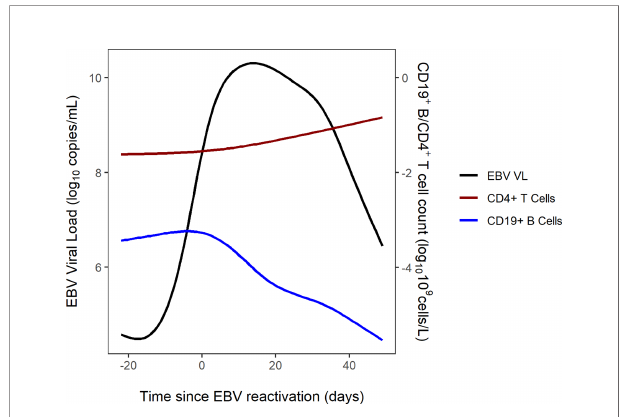
FIGURE 2 | Combined trajectories of EBV VL, CD19 + B cell and CD4 + T cell counts for 16 out of 56 patients.